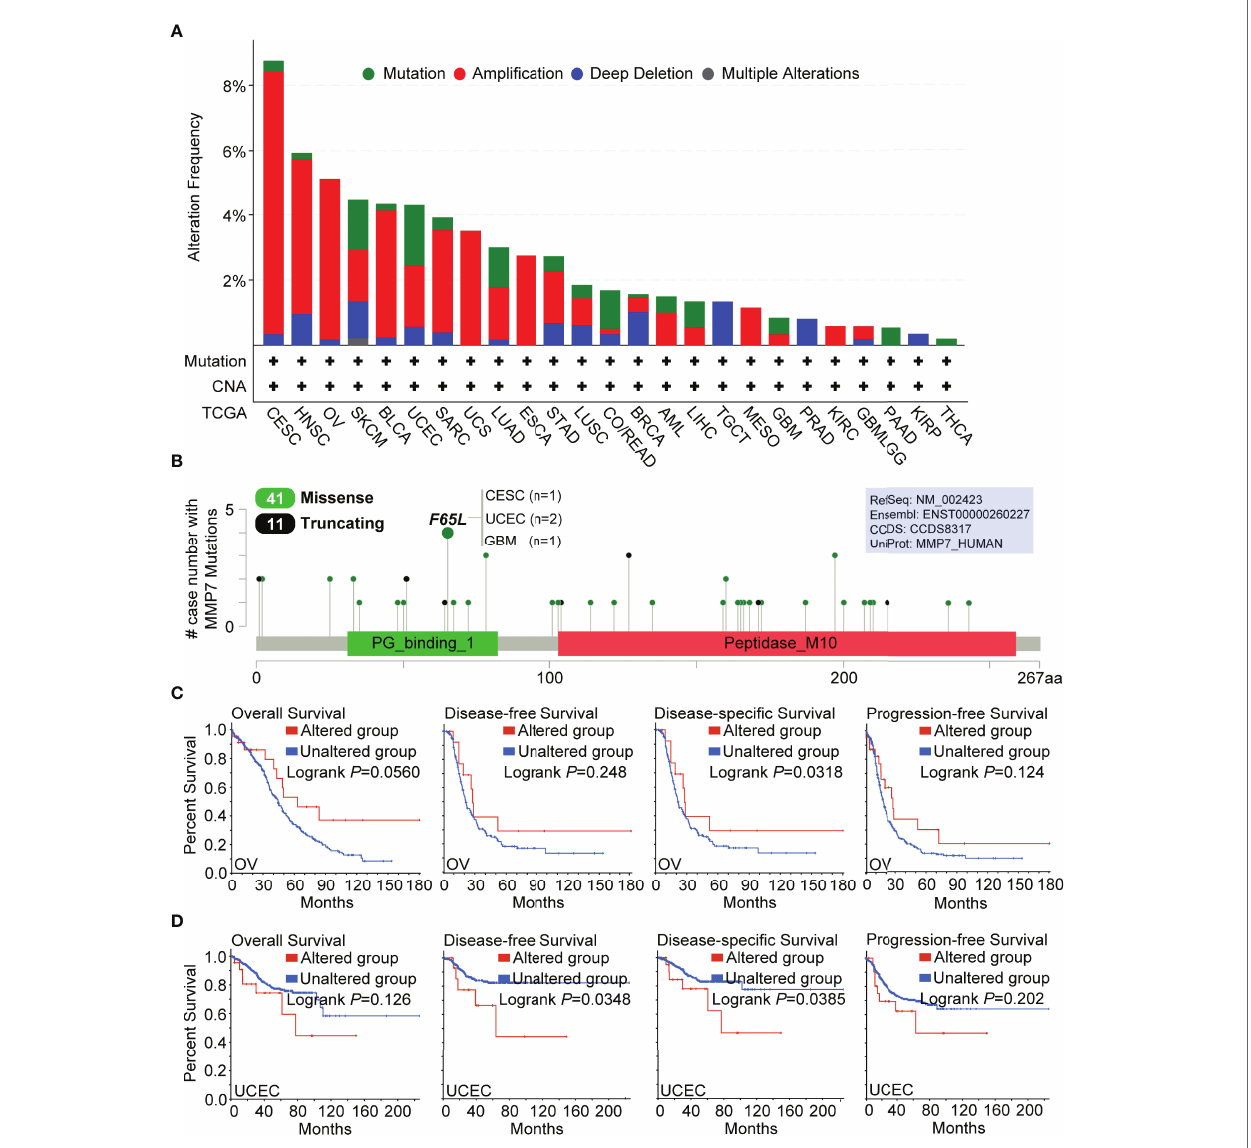
FIGURE 4 | Genetic alteration analysis of MMP7 by cBioPortal. (A) Summary of the alteration frequency for different mutation types in various cancers. (B) Presentation of the types, sites, and case number of MMP7 genetic alteration. The prognostic value of MMP7 genetic alteration was analyzed and the Kaplan – Meier curves of OS, DFS, disease- speci fi c survival, and progression-free survival in OV (C) and UCEC (D) are